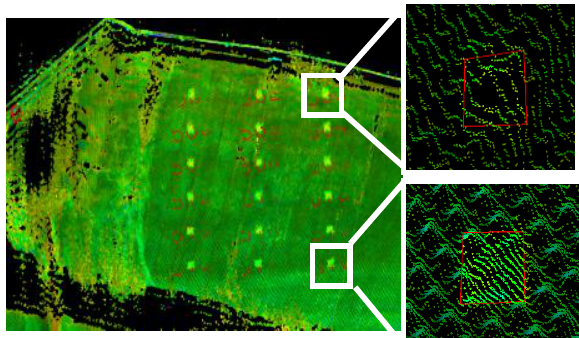
Figure 10. LiDAR data for evaluation of the developed boat- loading